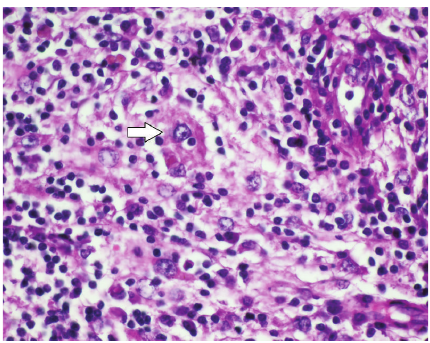
Figure 3: The image of the histiocyte that was observed to have emperipolesis in the histopathological examination (white arrow) (H&E, ×